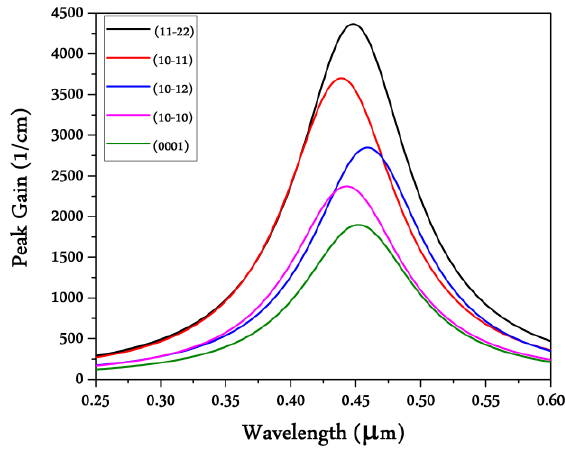
Figure 10. Orientation-dependent optical emission profile of In 0.17 Ga 0.83 N / GaN QW blue laser.